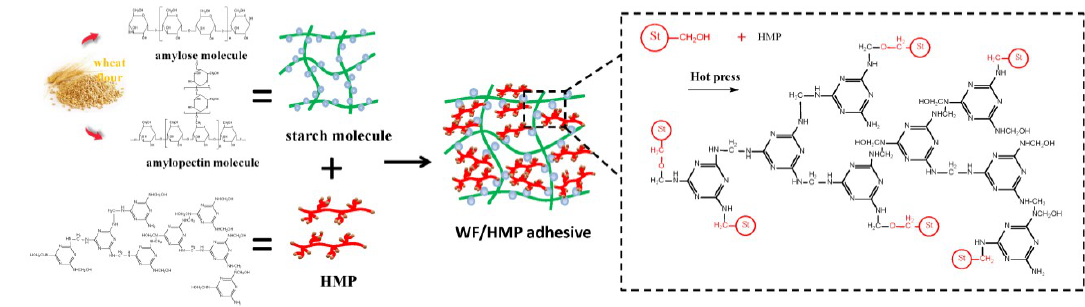
Figure 2. FTIR spectra of the different adhesive samples.